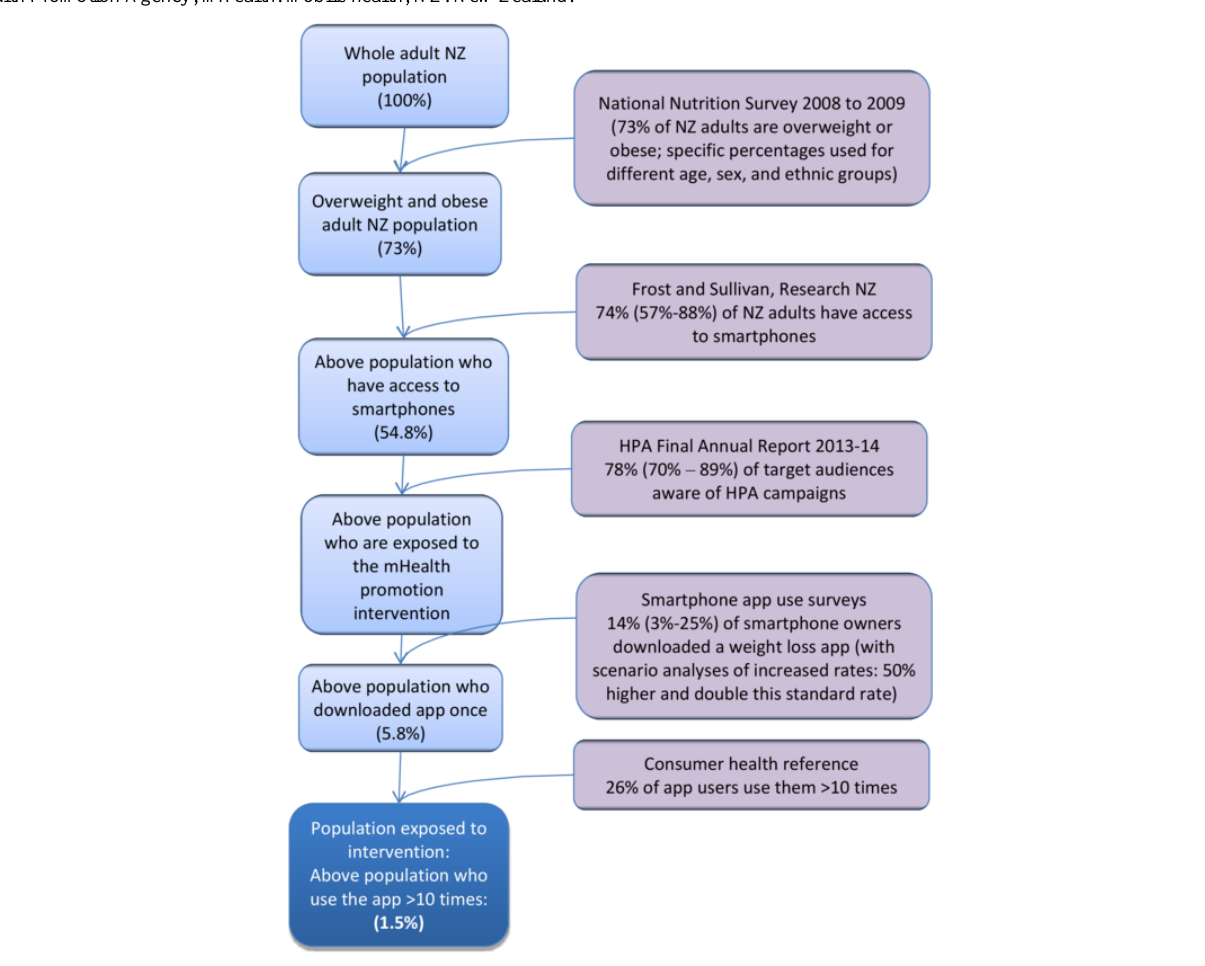
Figure 1. Flow diagram illustrating the targeting of the smartphone weight loss app promotion intervention in the New Zealand adult population. HPA: Health Promotion Agency; mHealth: mobile health; NZ: New